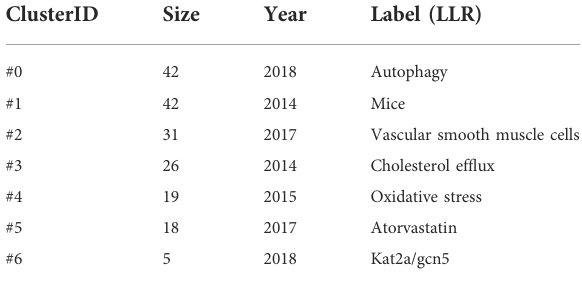
TABLE 6 Top seven clusters of